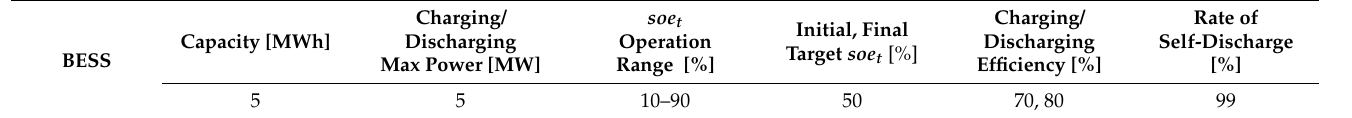
Table 2. Characteristics of BESS.